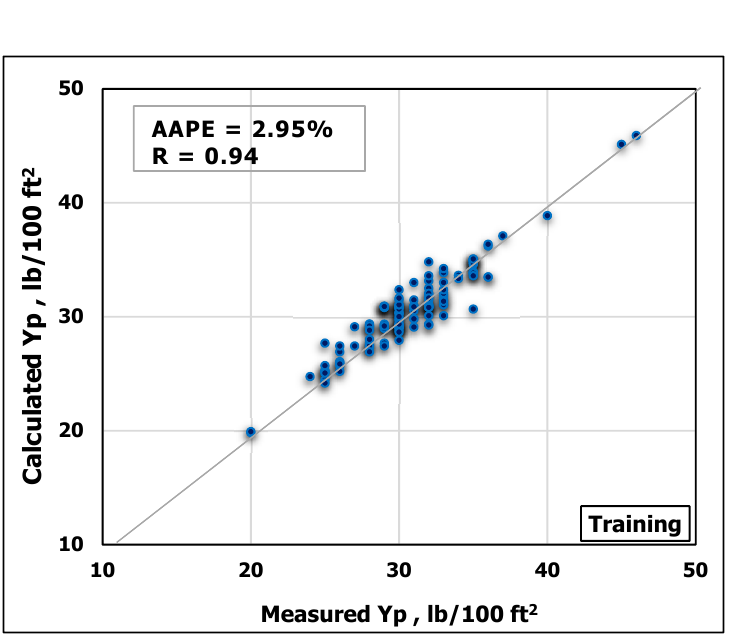
Figure 5. Measured Y P vs. predicted Y P from the ANN model for the training process.